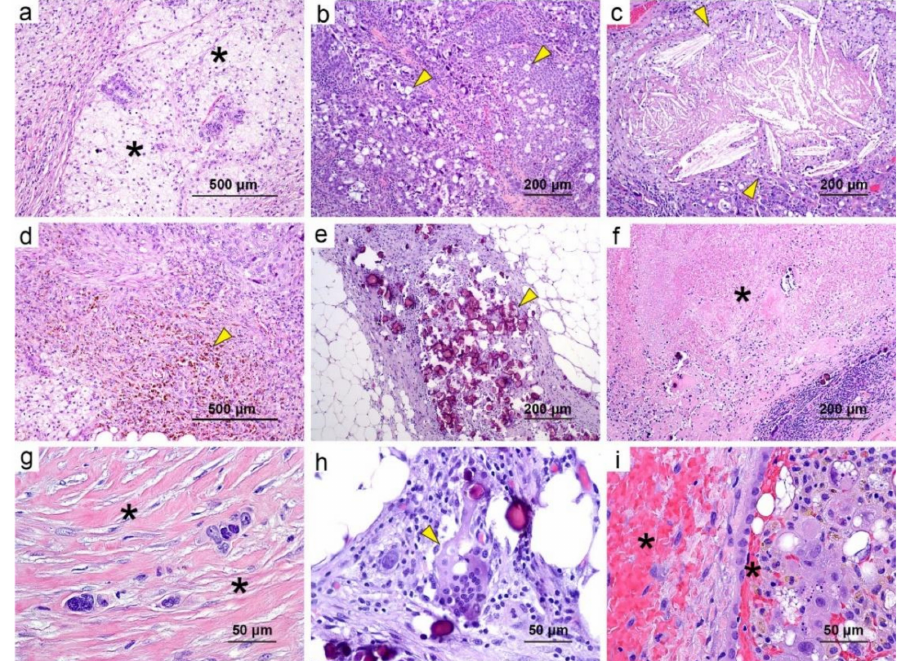
Figure 4. Representative examples of the histologic features that were not significantly associated with survival in our cohort (H&E staining; scale bars: ( a , d ) 500 µ m, ( b , c , e , f ) 200 µ m, ( g – i ) 50 µ m). ( a ) Foamy histiocytes (black asterisks), score: 3; ( b ) eosinophilic cytoplasm with vacuolization (yellow arrows), score: 2; ( c ) cholesterol crystal (yellow arrow), score: 2; ( d ) hemosiderin deposition (yellow arrow), score: 2; ( e ) calcification/psammoma bodies (yellow arrow), score: 2; ( f ) necrosis (black asterisk), score: 2; ( g ) scarry fibrosis (black asterisks), score: 2; ( h ) foreign body giant cells (yellow arrow), score: 1; ( i ) hemorrhage (black asterisks), score: 1.